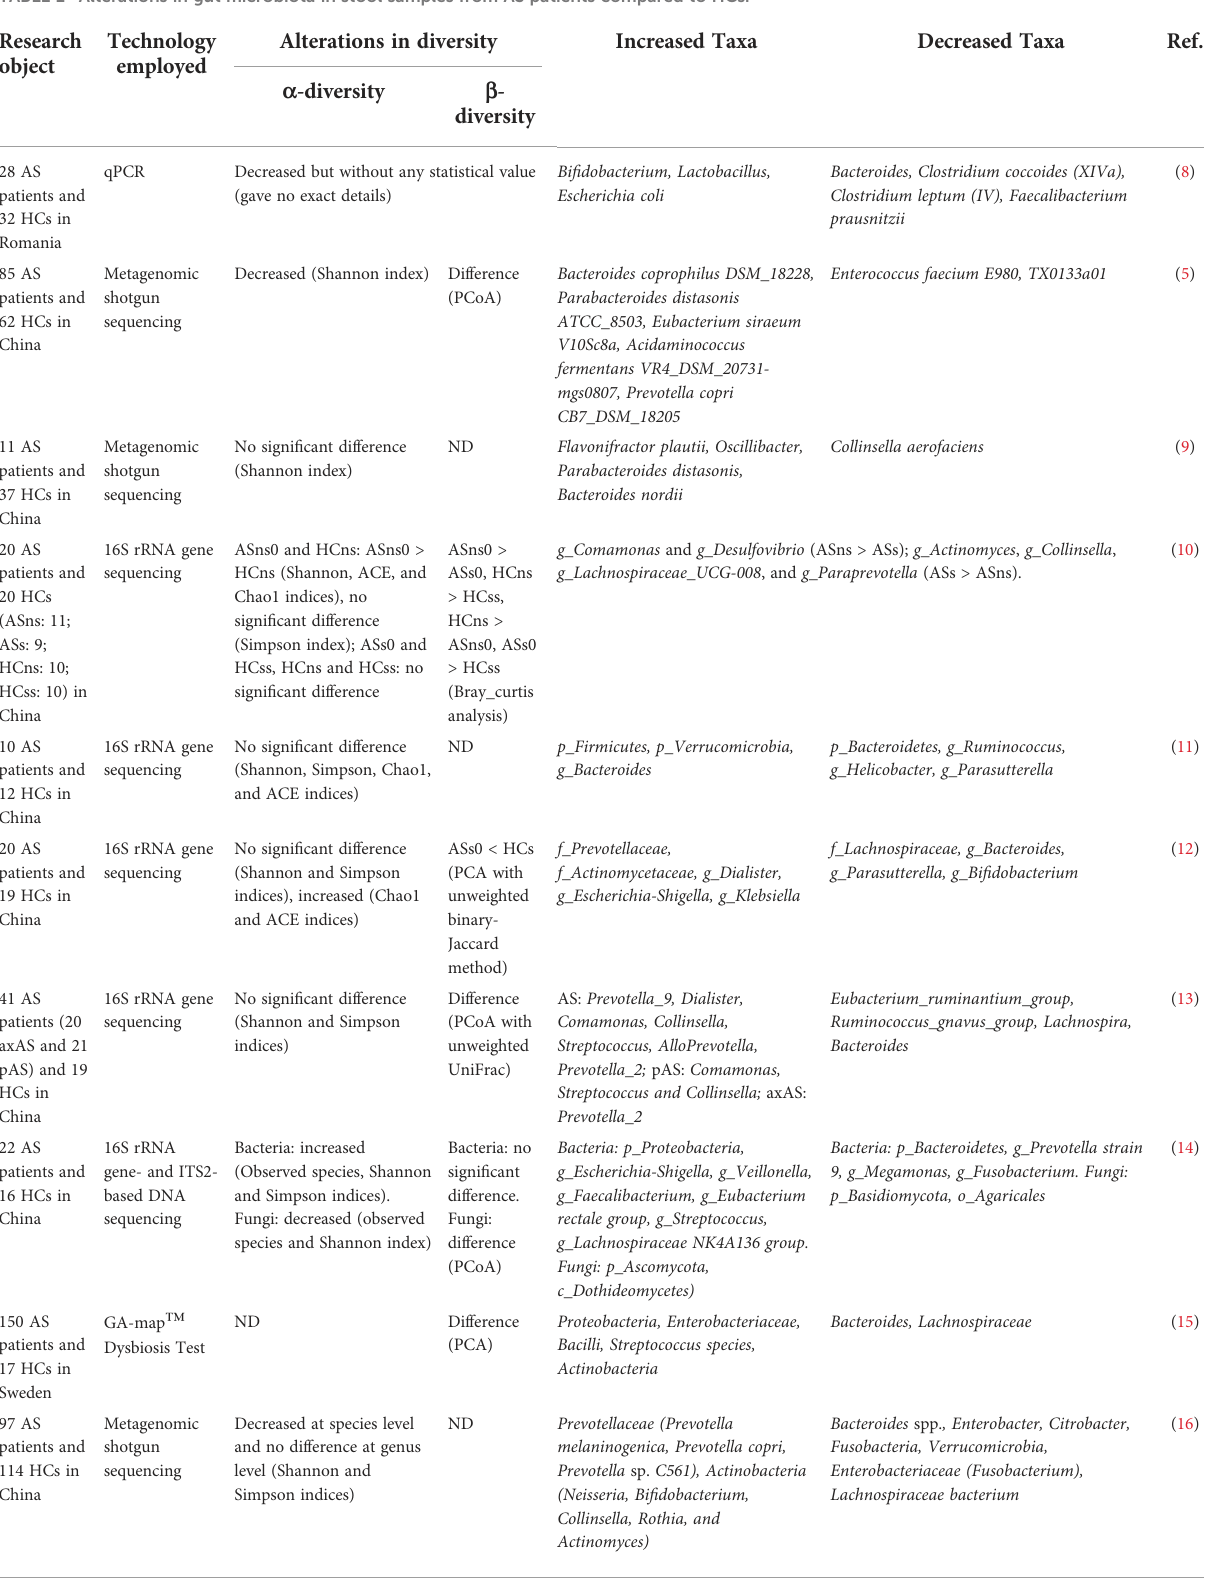
TABLE 1 Alterations in gut microbiota in stool samples from AS patients compared to